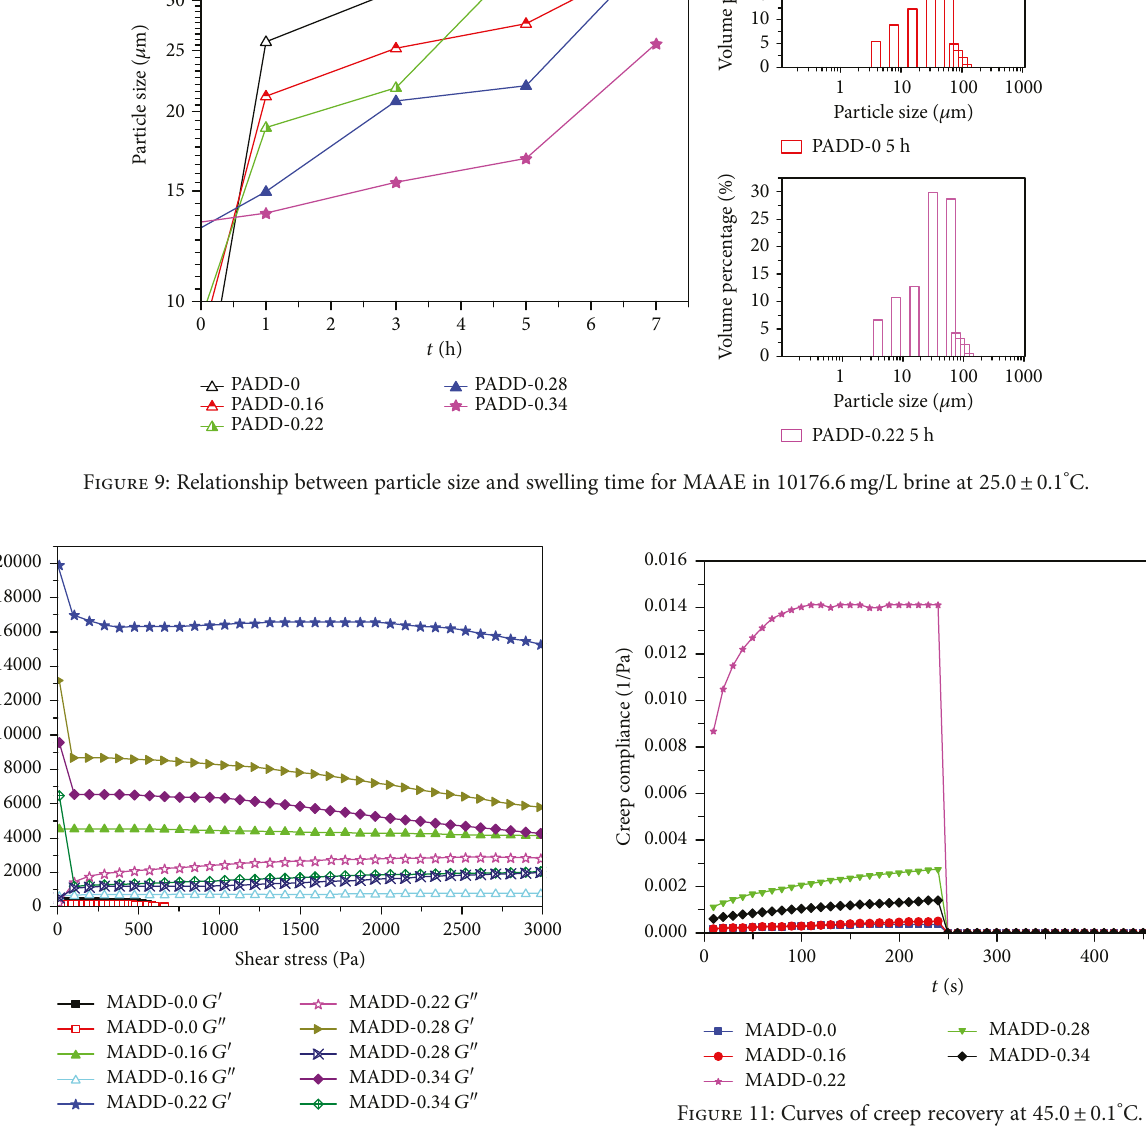
Figure 10: Curves of storage modulus, loss modulus, and shear stress at 45.0 ± 0.1 ° C.